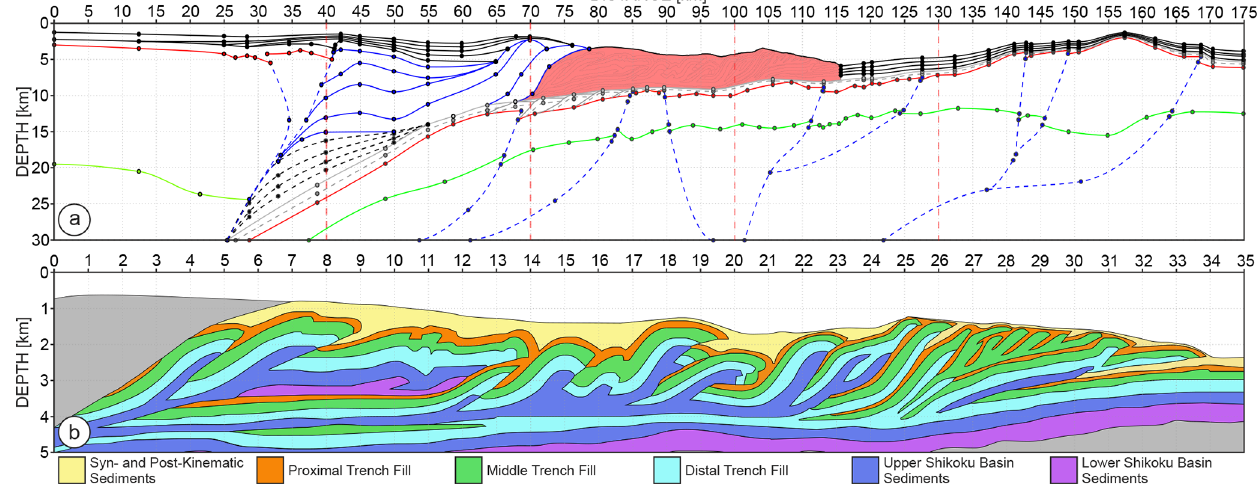
Figure 2. (a) 2D structural skeleton – inline section at y = 0km; lines represent interfaces: solid black – shallow sediments; solid blues – inner wedge; solid red – top of the crust; solid green – Moho; dashed black – underplated sediments; grey – subducting sediments; dashed blue – major faults; shaded red denotes outer wedge. (b) Structure of the accretionary prism adopted form (Kington,